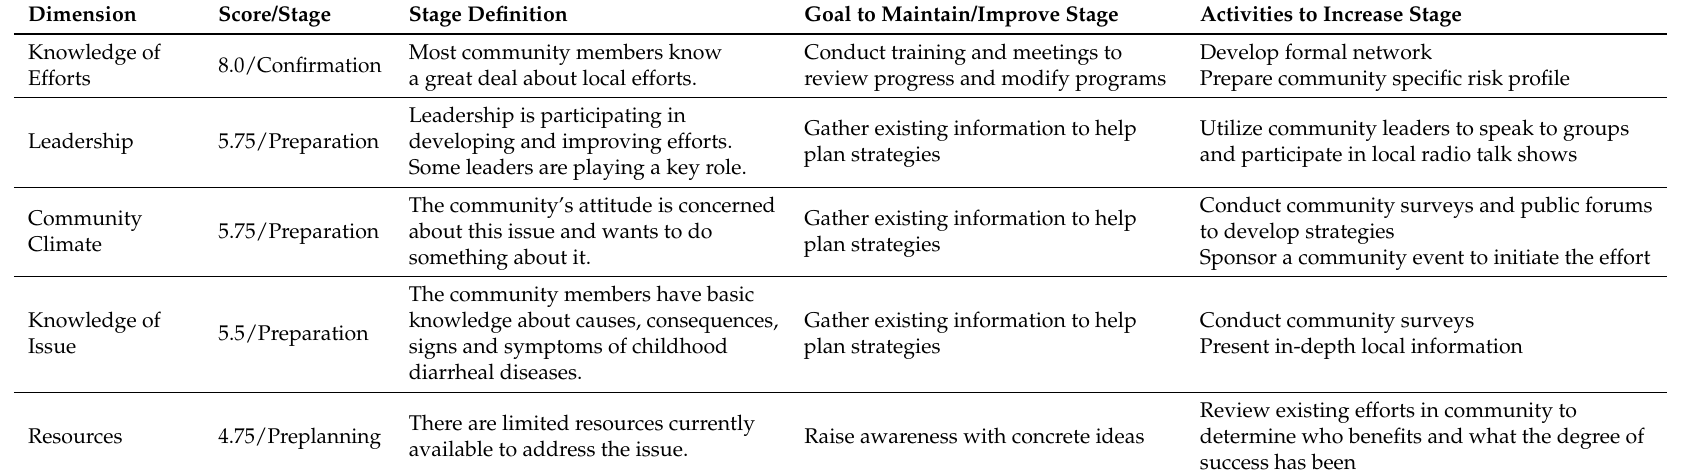
Table 3. Proposed activities to increase community readiness for reducing childhood diarrheal diseases according to each dimension (adapted from [10]).